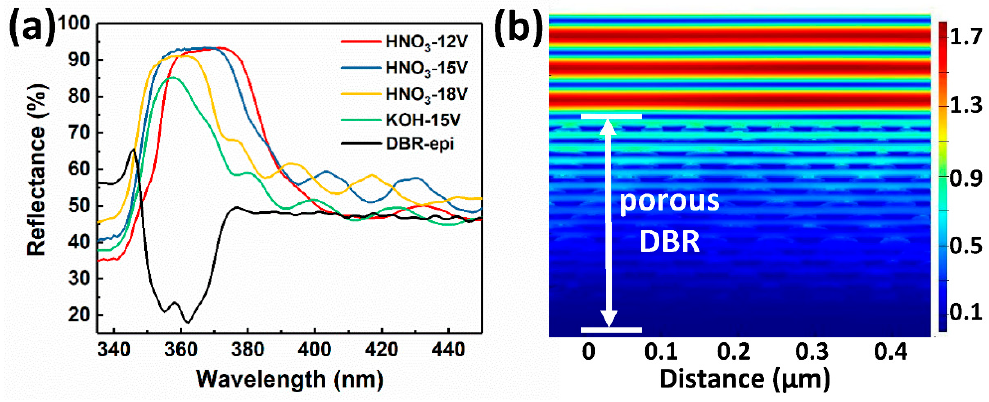
Figure 3. ( a ) The reflectance spectra of porous AlGaN DBRs etched in HNO 3 and KOH solutions. ( b ) Simulated electric field distribution of porous DBR (HNO 3 -15 V) by FDTD.